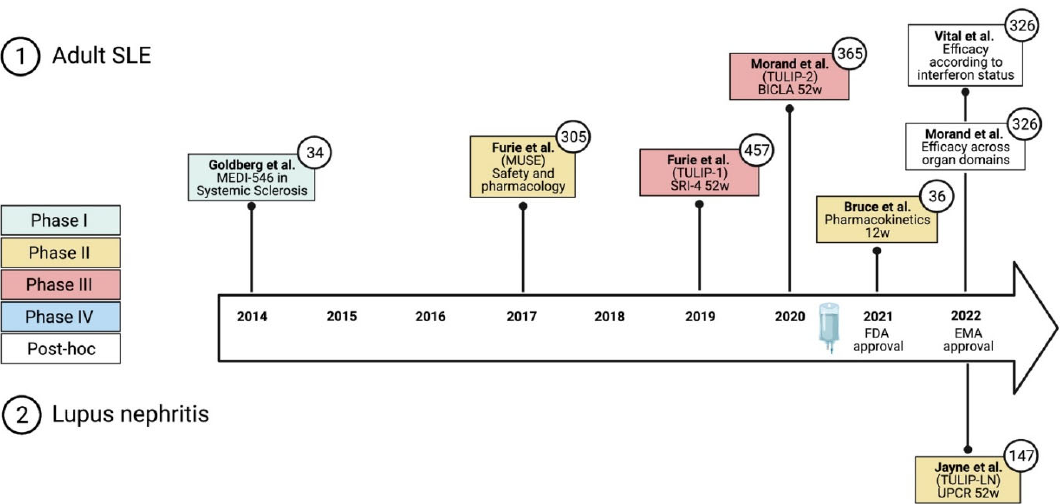
Figure 4. Timeline of major clinical trials, primary outcome measures, and authorization of anifrolumab [1–8]. BICLA, British Isles Lupus Assessment Group ‐ based composite lupus assessment; EMA, European Medicines Agency; FDA, Federal Drug Agency; SC, subcutaneous; SRI ‐ 4, systemic lupus erythematosus responder index ‐ 4; UPCR, urine protein–creatinine ratio; w, weeks. Numbers in circles denote the number of participants. Created with biorender.com.